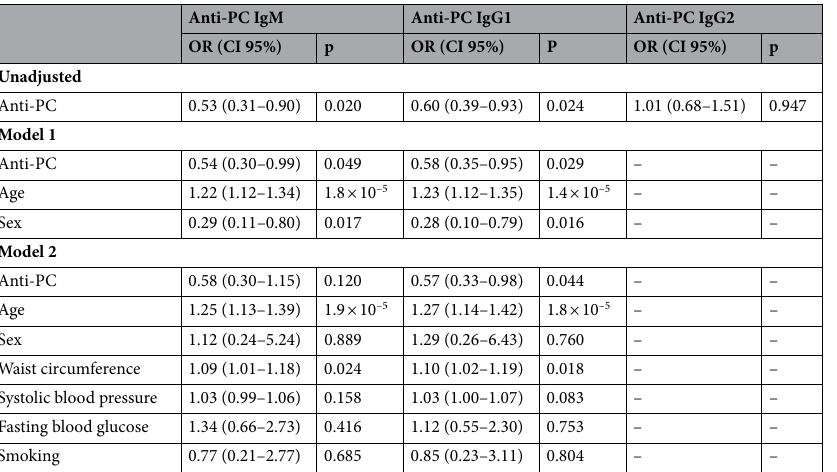
Table 2. Associations between anti-PC and risk of being a hospitalized obese subject (HO). Values are odds ratios (OR) with 95% confidence intervals (CI 95%). Anti-PC antibodies against phosphorylcholine,